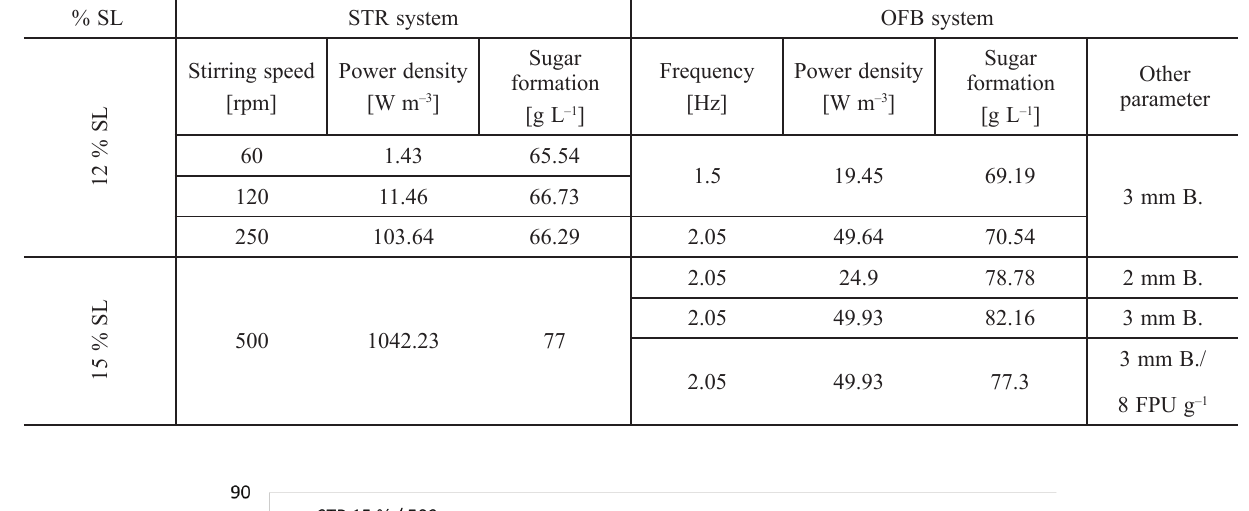
Table 4 – Overview of experimental data: STR – OFB system comparison